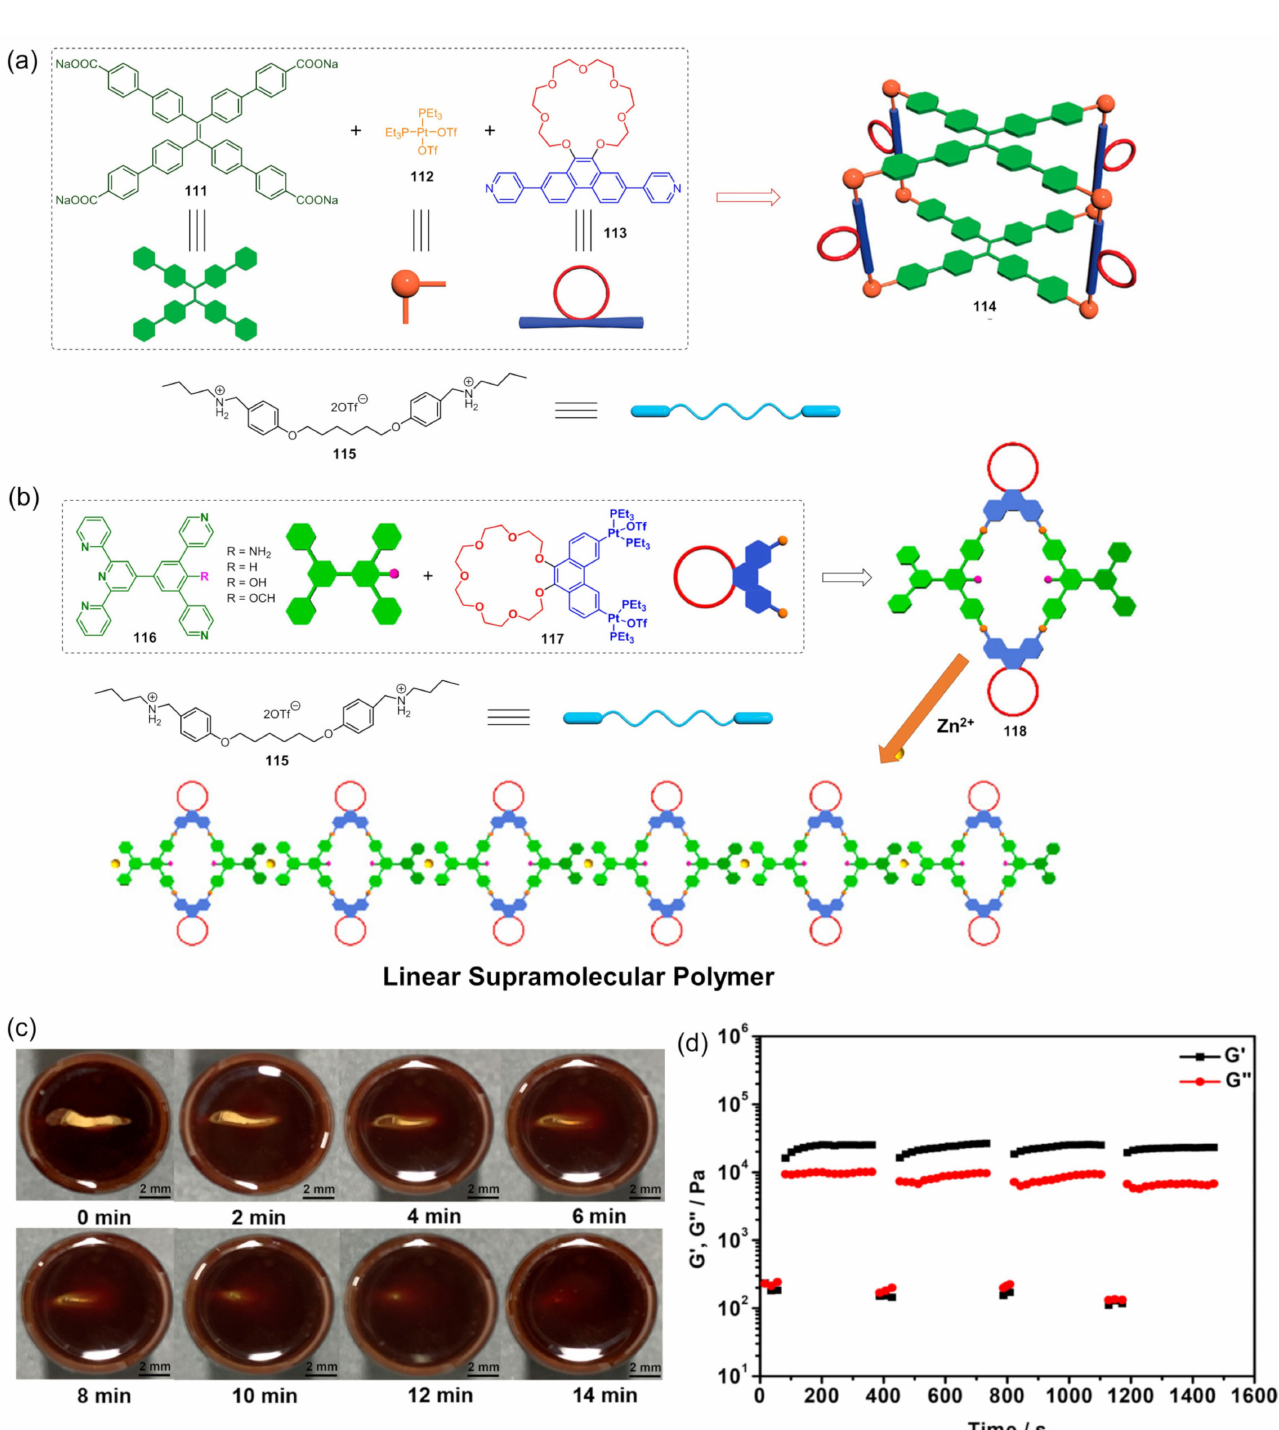
Figure 49. ( a ) Self-assembly of 21C7-Functionalized Metallacage 114 and molecular structure of bis-ammonium salt 115 . ( b ) Cartoon representation of the formation of rhomboidal metallacycles 118 , a linear supramolecular polymer from metallacycles and Zn 2+ , and molecular structure of bis- ammonium salts 115 . ( c ) Photographs of the self-healing process of the supramolecular gel. The gel was cut and left to stand for 2, 4, 6, 8, 10, 12 and 14 min, respectively. ( d ) Gel in continuous step-strain measurements. Reprinted with permission from Refs. [130,131]. Copyright (2018, 2019), American Chemical